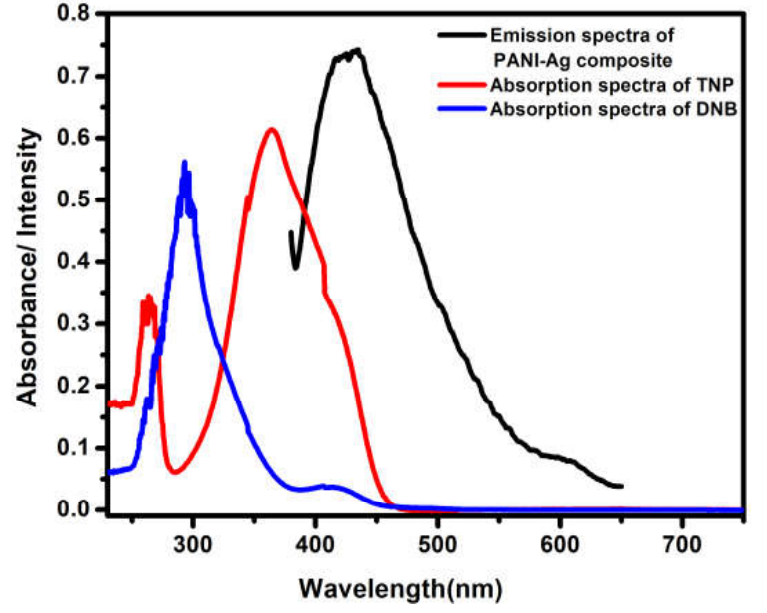
Figure 12. Absorbance spectra of TNP and emission spectra of the PANI-Ag composite.